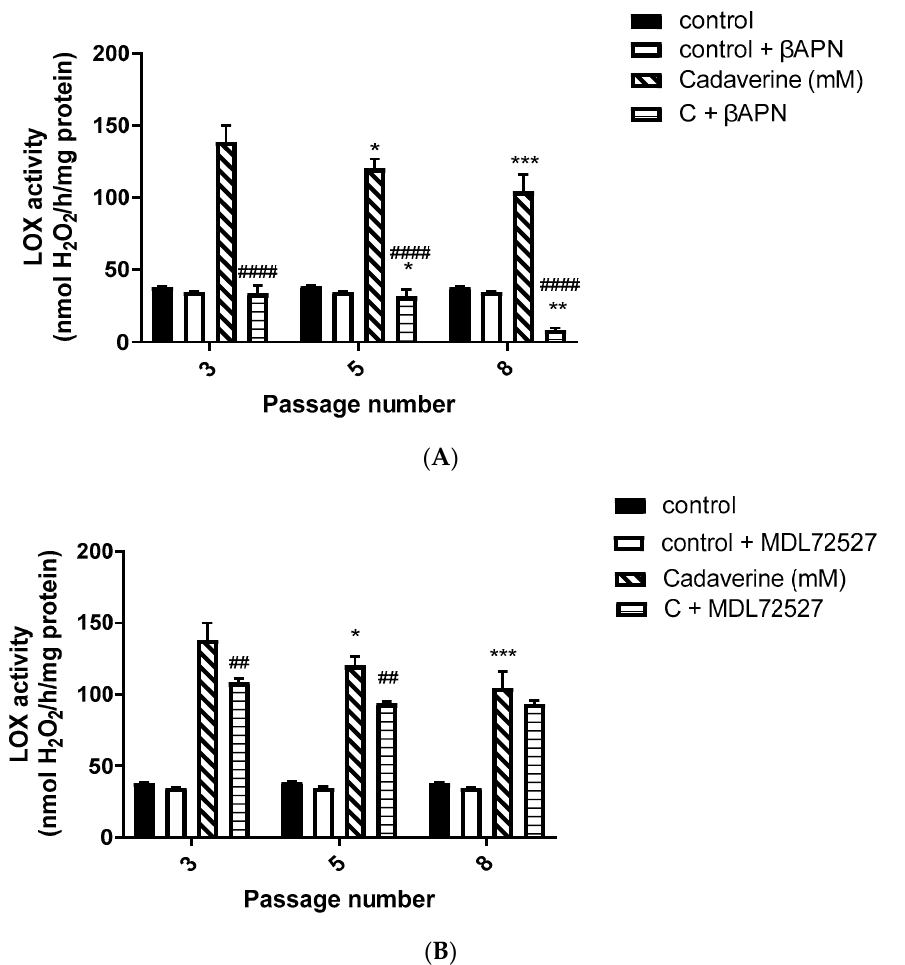
Figure 2 . LOX activity in VSMCs from passages 3, 5, and 8 at the basal level, and after β APN and MDL72527 treatment. ( A ) Cells were treated with a reaction mixture containing 0.5 mM cadaverine (hatched bars); 0.5 mM cadaverine + 200 μ M β APN (horizontal line bars); a reaction mixture without cadaverine (control — solid bars) and a reaction mixture without cadaverine + β APN (control + β APN, open bars). * p < 0.05 for cells passage 5 vs . 3 and *** p < 0.001 for cells passage 8 vs. 3 after treatment with cadaverine; ** p < 0.01 for cells passage 8 vs . 3 and * p < 0.05 for cells passage 5 vs . 8 after treatment with cadaverine + β APN; #### p < 0.0001 for C + β APN vs . cadaverine at passages 3, 5, and 8. ( B ) Cells were treated with a reaction mixture containing 0.5 mM cadaverine (hatched bars); 0.5 mM cadaverine + 100 μ M MDL72527 (horizontal line bars); a reaction mixture without cadaver- ine (control — solid bars) and a reaction mixture without cadaverine + MDL72527 (control + MDL72527, open bars).* p < 0.05 for cells passage 5 vs . 3 and *** p < 0.001 for cells passage 8 vs . 3 after treatment with cadaverine; ## p < 0.01 for C + MDL72527 vs . cadaverine at passages 3 and 5. Values are mean ± S.E.M. (n = 5).